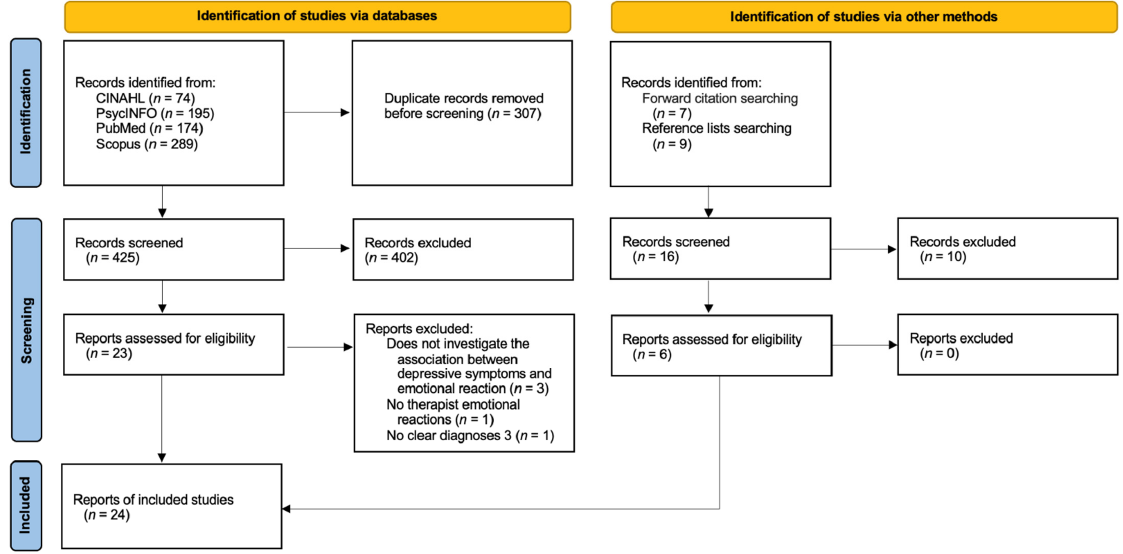
Figure 1. PRISMA diagram of study selection process.